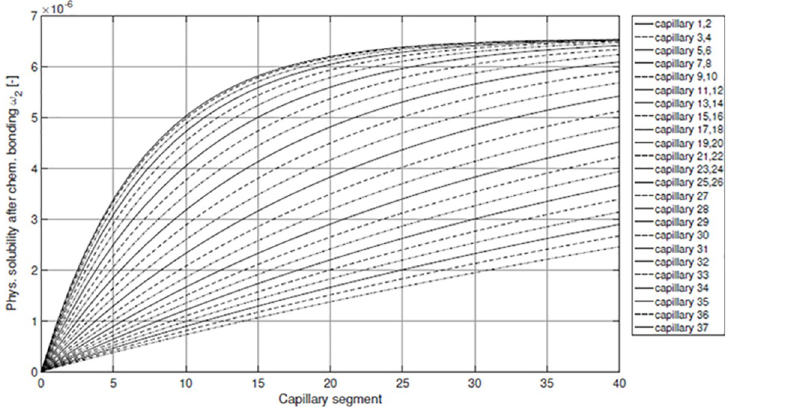
Fig 14. Mass fraction of physical solute O 2 in the hemolymph along each capillary.